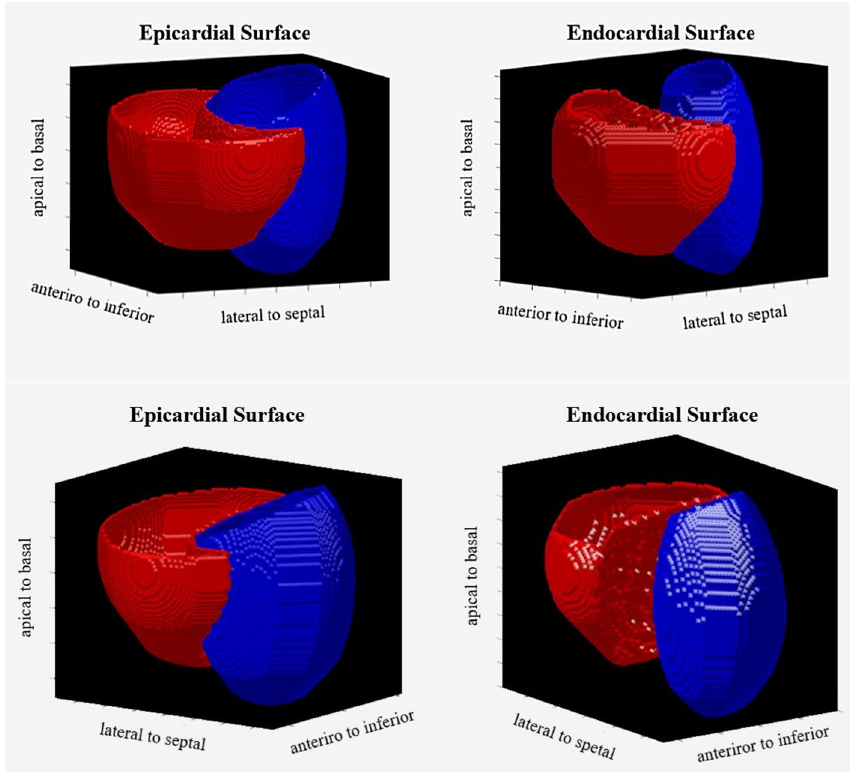
Fig. 3 A sample of the 3D surface rendering image. Left ventricular (blue) and right ventricular (red) are segmented. Epicardial and endocardial surfaces are illustrated from two different view angles (top and bottom